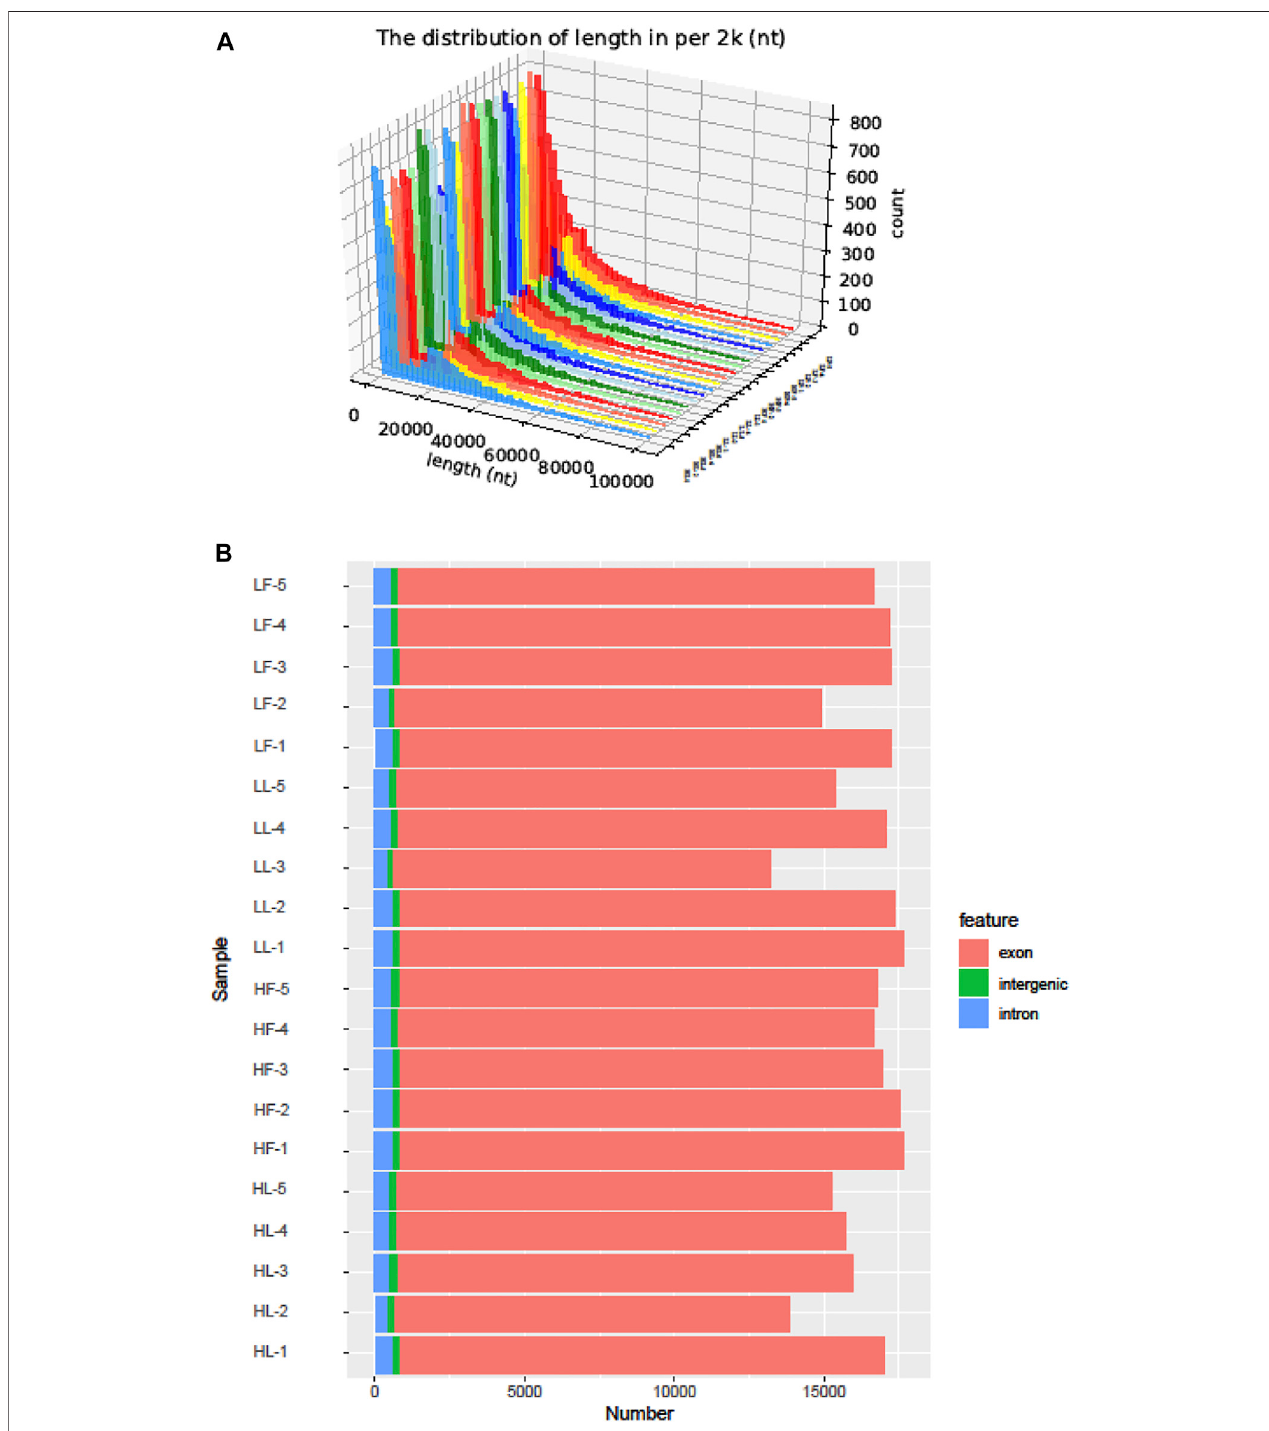
FIGURE 1 | The identi fi cation of circRNAs in goat ovarian tissues. (A) : Length distribution of circRNAs. (B) : Function region statistics of circRNAs.